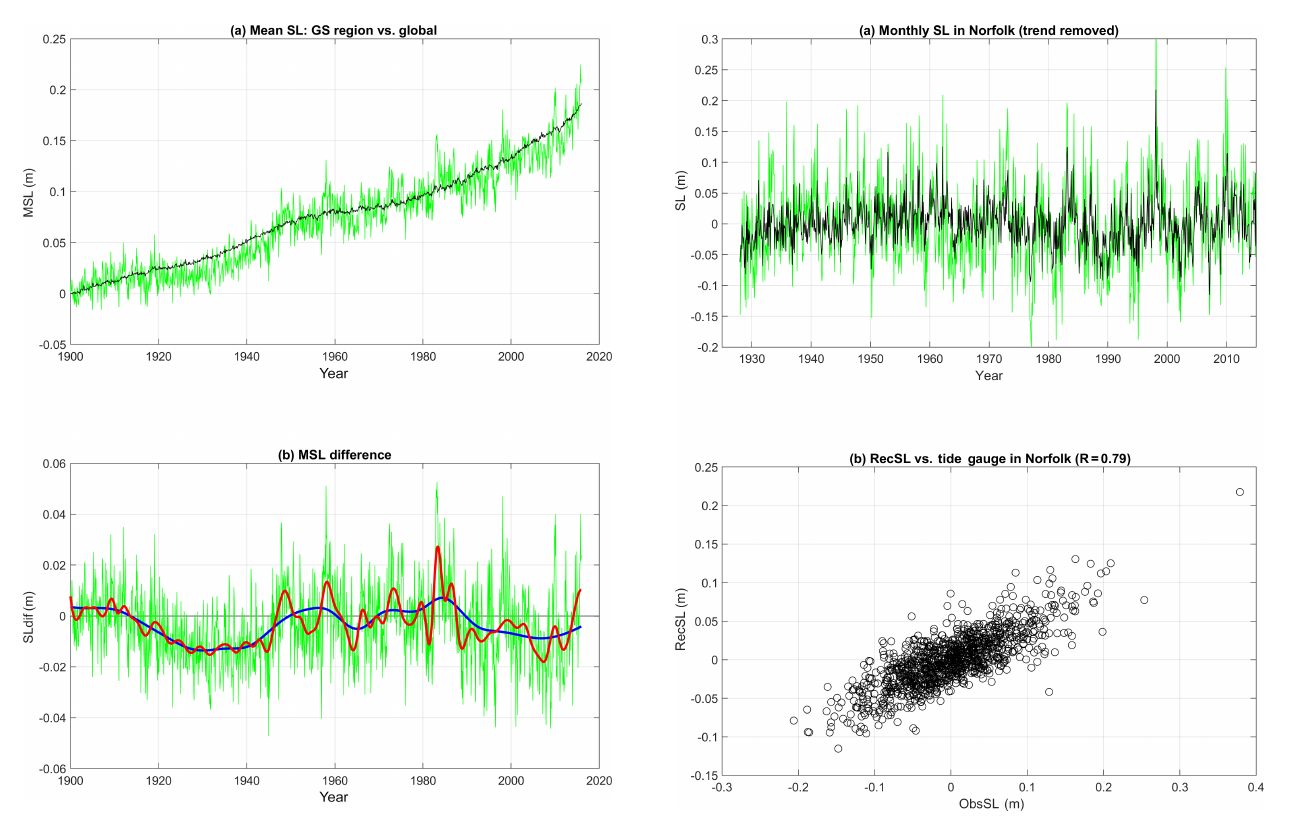
Figure 4. (a) Comparison of the monthly observed coastal sea level (green line) at the tide gauge near Norfolk, VA (76.33 ◦ W, 36.95 ◦ N; see Fig. 1), and the reconstructed sea level (black line) in the closest 1 ◦ × 1 ◦ box near the coast. (b) Scatter plot of the data comparison. The trend and the seasonal cycle were removed from both time se-